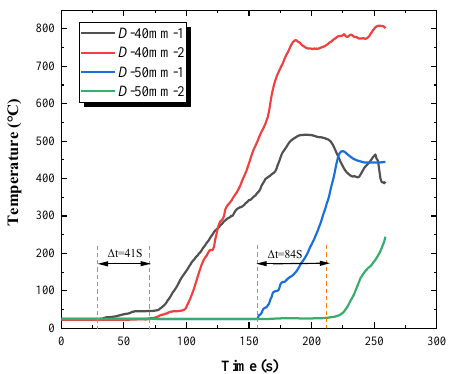
Figure 7. Front view of combustion temperature field.